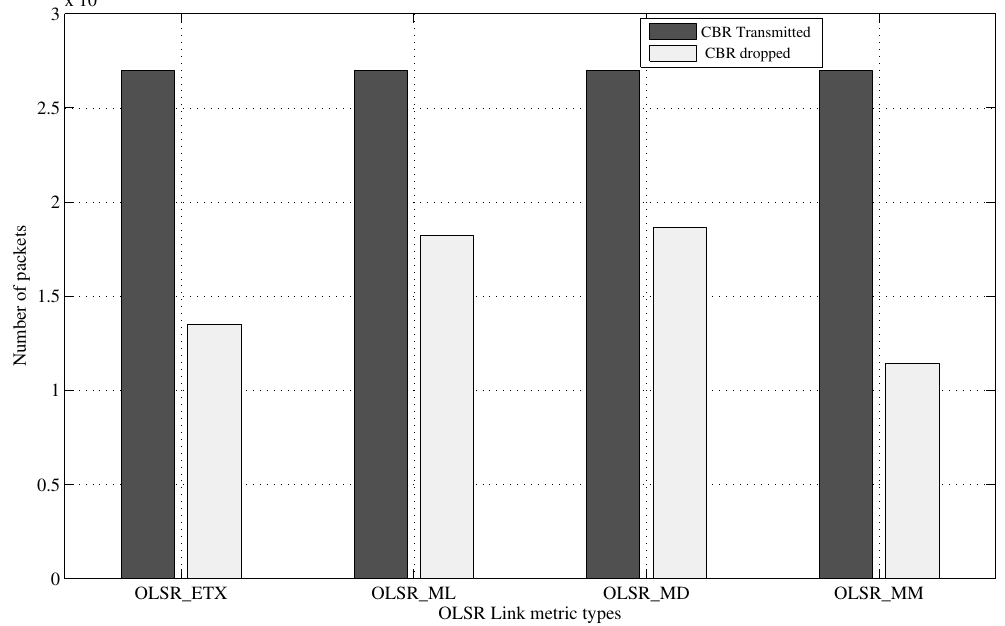
Figure 5. Transmitted and dropped CBR packets for EV